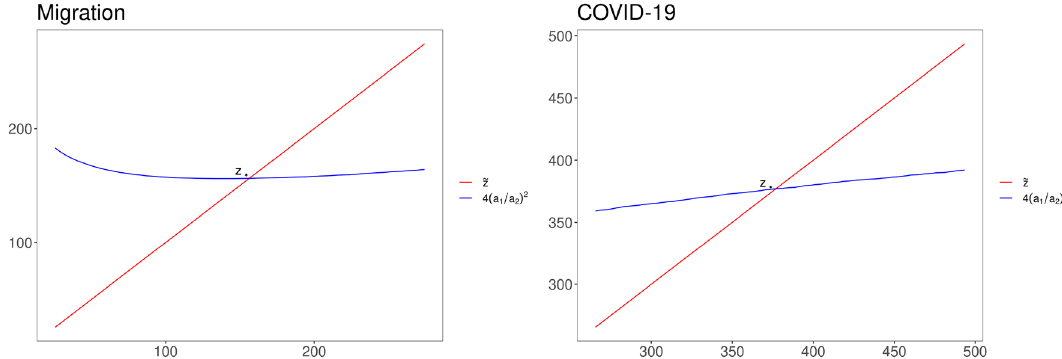
based on Eq. (14): (Left) Migration; (Right) ∗